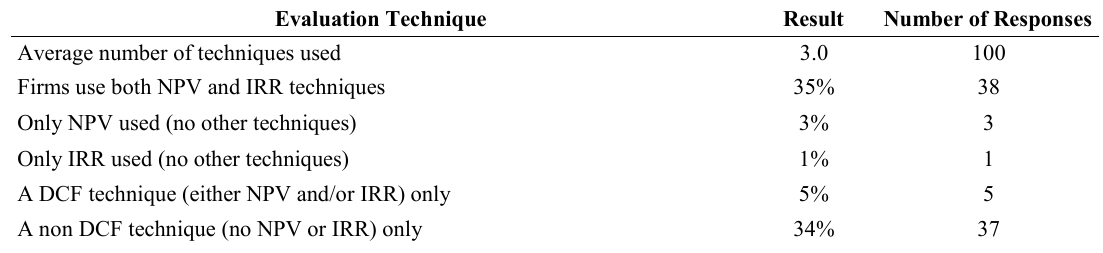
Table 4. Combination of techniques used to evaluate capital expenditure projects Evaluation